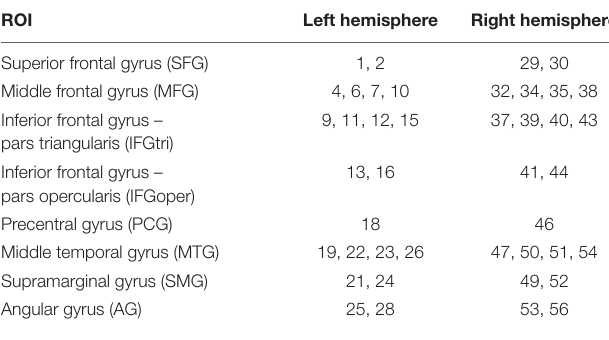
TABLE 2 | Channels assigned to regions of